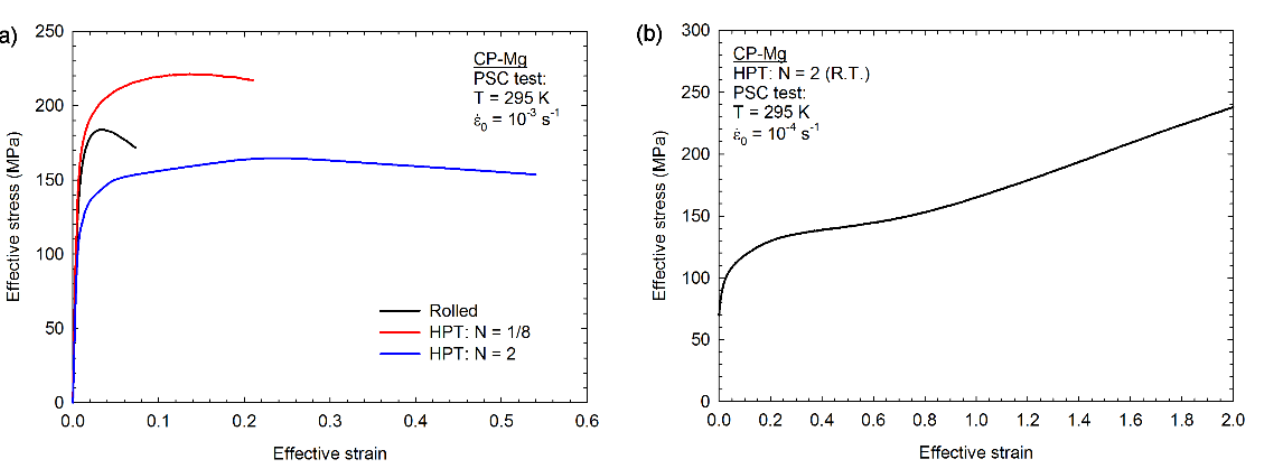
Figure 7. Stress vs. strain curves for pure magnesium determined in PSC tests at initial strain rates of ( a ) 10 − 3 s − 1 and ( b ) 10 − 4 s − 1 .